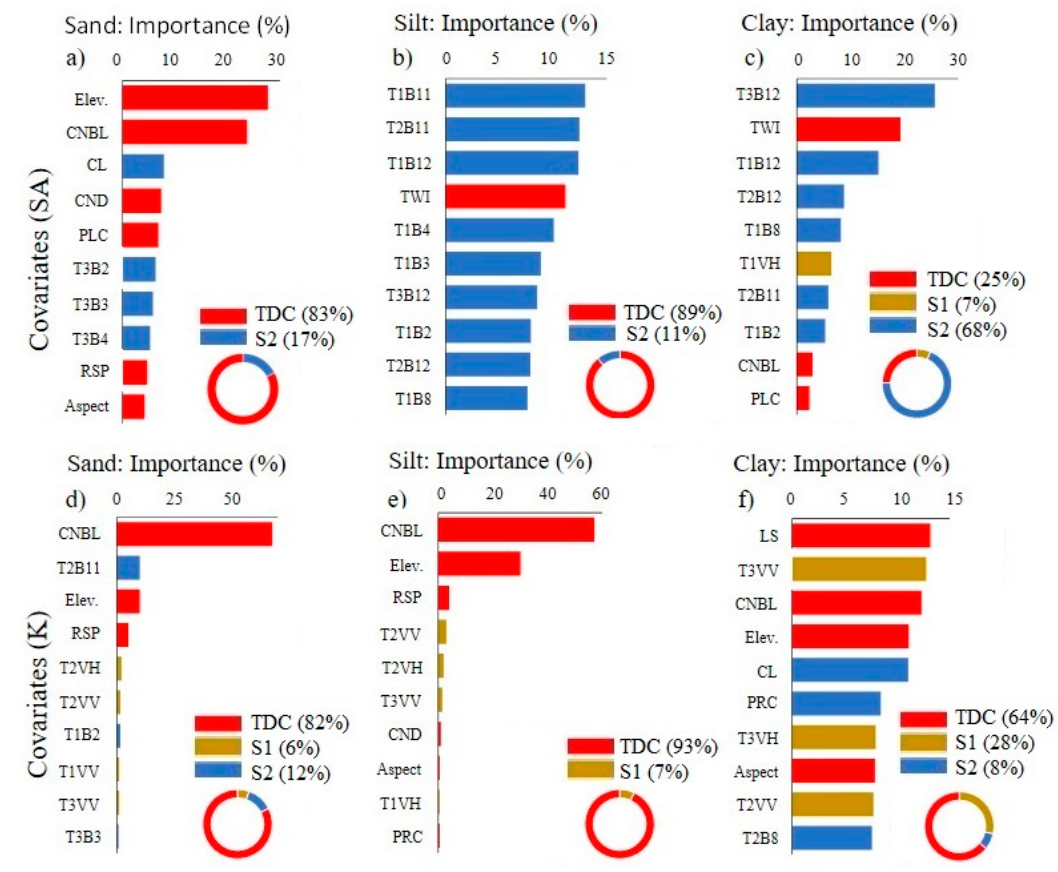
Figure 3. Importance of covariates for predicting the best-fitted models for soil texture fractions in SA ( a – c ) and K ( d – f ) regions. (Refer to Table 1 for TDC.)